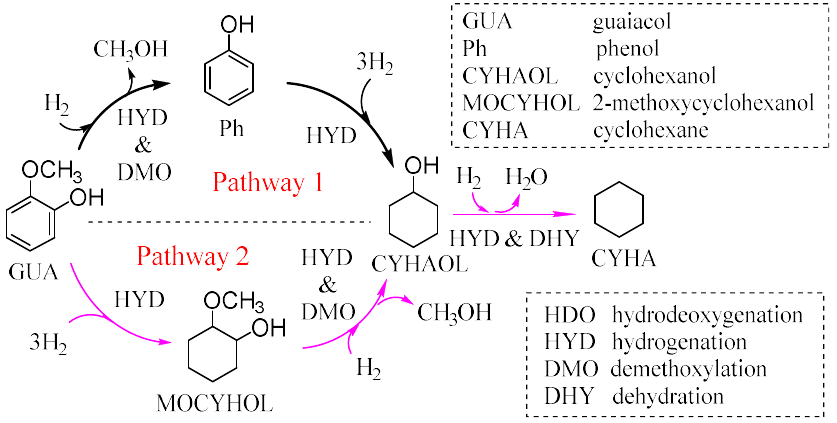
Scheme 1. Possible reaction pathways in the HDO of GUA over the Co/rGO catalyst.